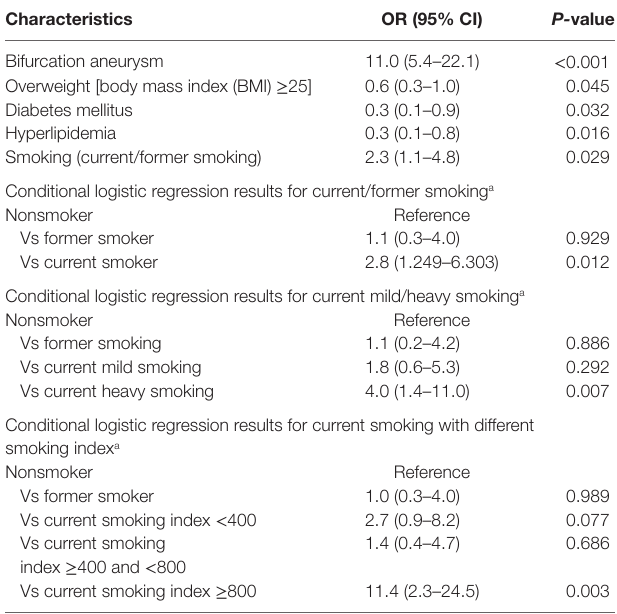
TaBle 3 | Conditional logistic regression analysis related to intracranial aneurysm rupture.